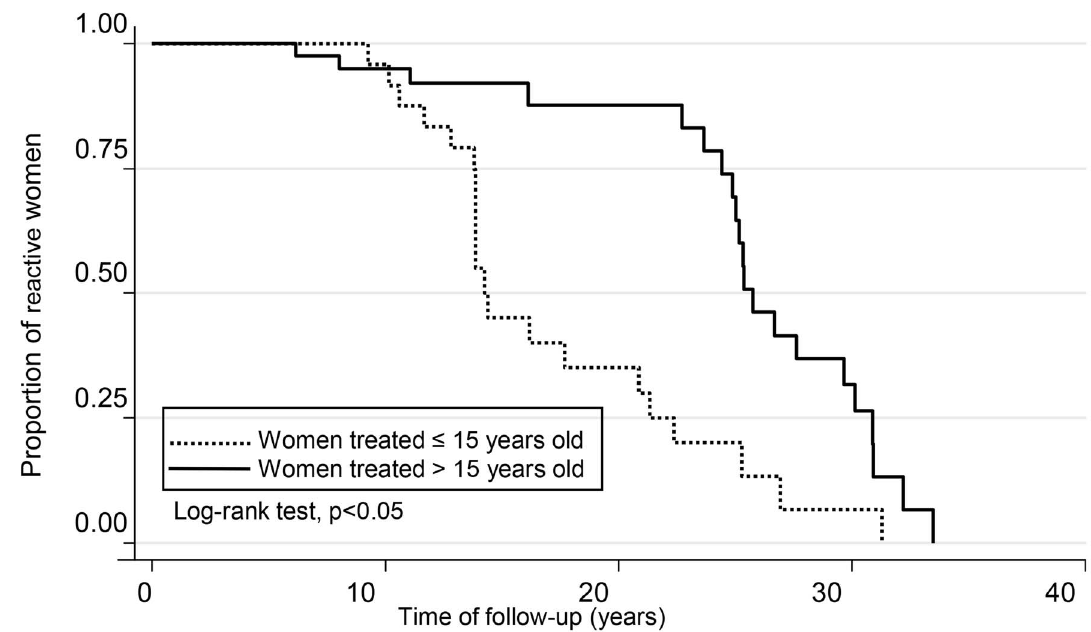
Figure 4. Kaplan-Meier curve showing serological reactivity rate by age during follow-up in 71 treated women.